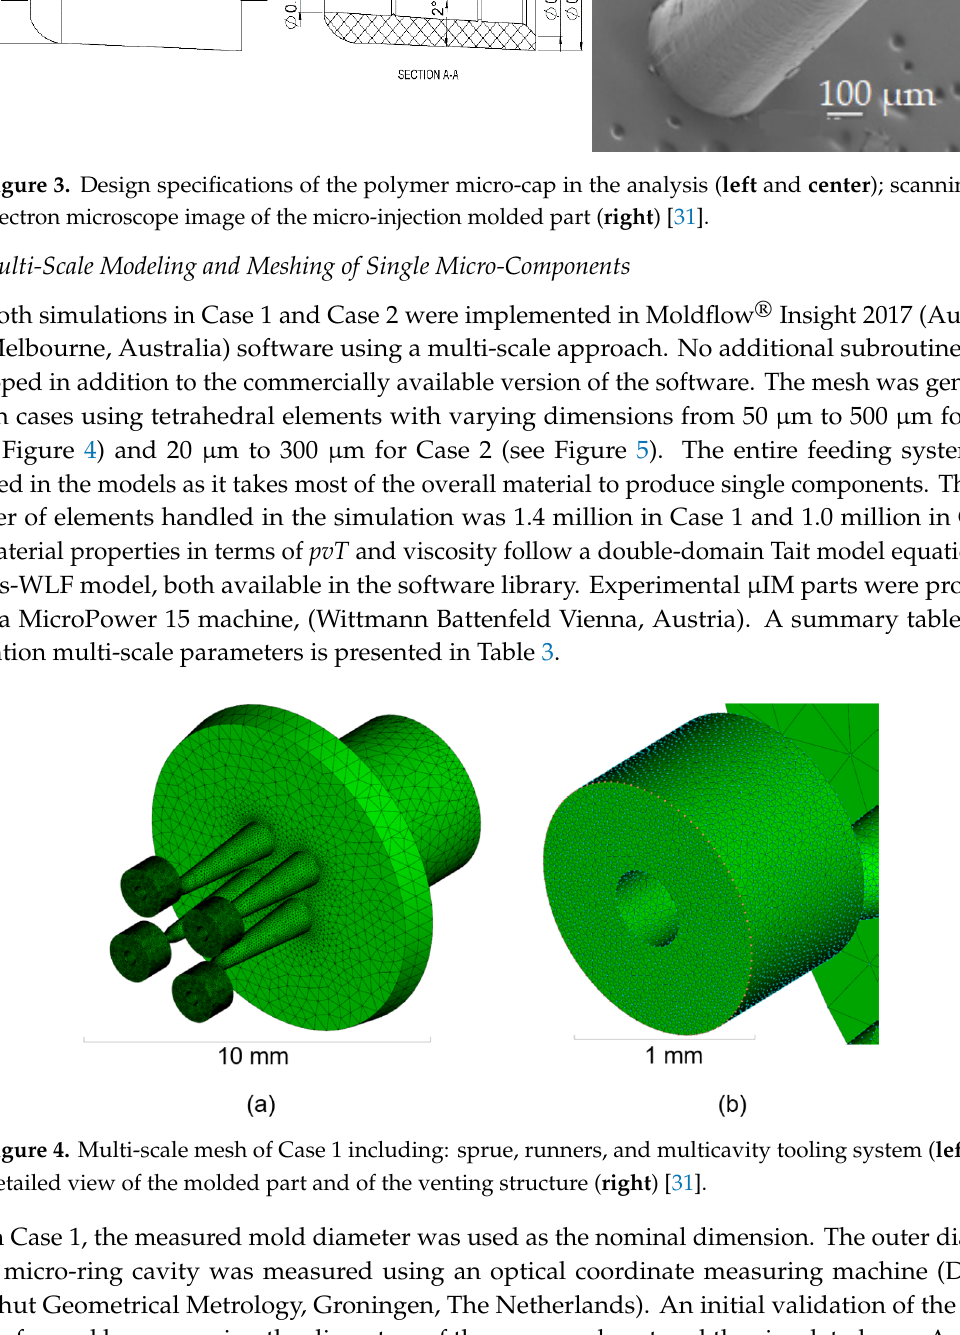
Figure 4. Multi-scale mesh of Case 1 including: sprue, runners, and multicavity tooling system ( left ); detailed view of the molded part and of the venting structure ( right ) [31].